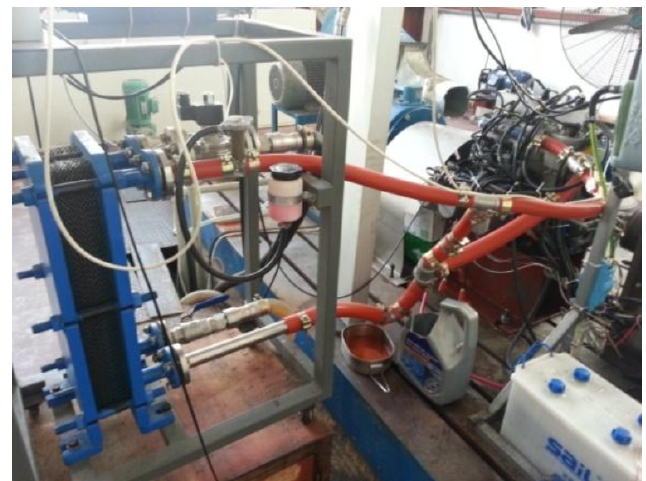
Figure 10. Cooling device.